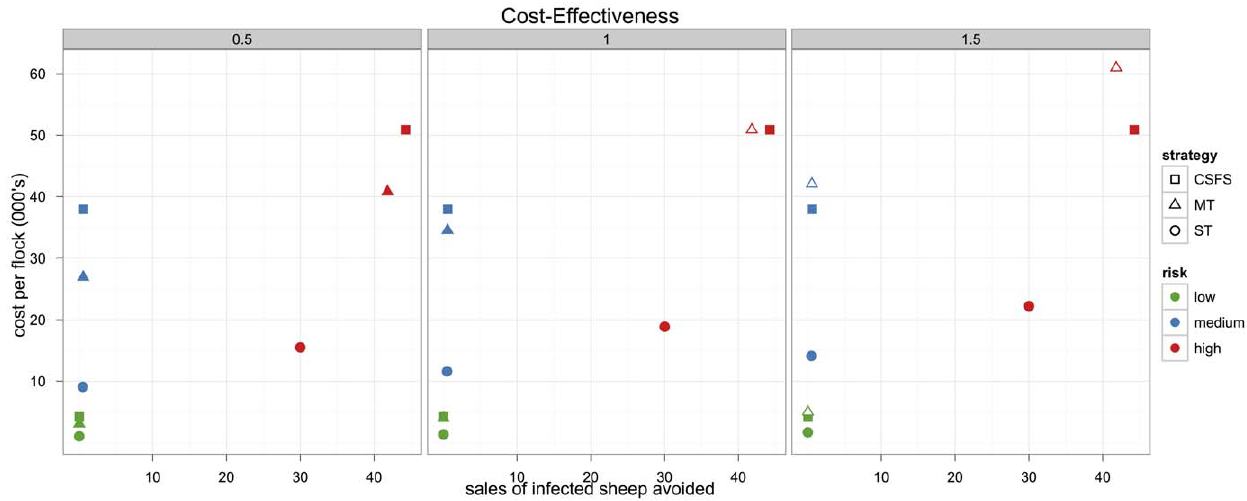
Figure 3. Cost-effectiveness plane examining all flocks (high, moderate and low risk) assuming 40% proportion of susceptible genotypes under three preclinical test unit costs (0.5, 1.0 and 1.5 times threshold price that would give CSFS and MT equal costs). The MT strategy is clearly dominated in the 1.5 times scenario having a much greater cost than CSFS with lower effectiveness (fewer infected sheep sales avoided.).